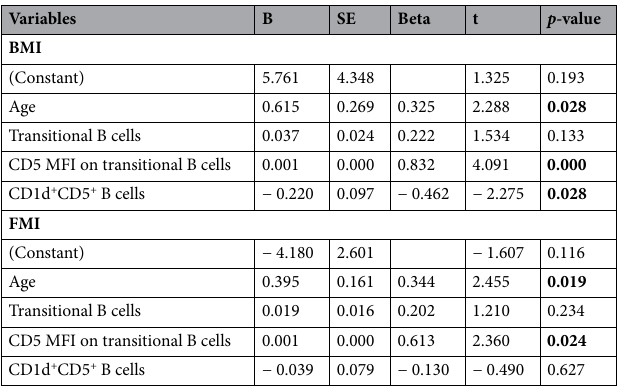
Table 2. Multivariate linear regression analyses of BMI and FMI in anorexia nervosa. Significant effects are in bold print. MFI mean fluorescence intensity Body mass index (BMI): F = 5.193, df (4,39), p = 0.002; R = 0.590, R 2 = 0.348. Fat mass index (FMI): F = 5.217, df (4,37), p = 0.002; R = 0.601, R 2 =